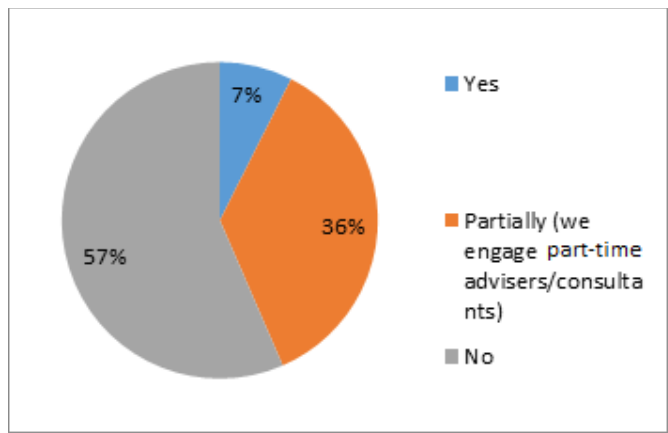
Figure 4: Availability of dedicated lean